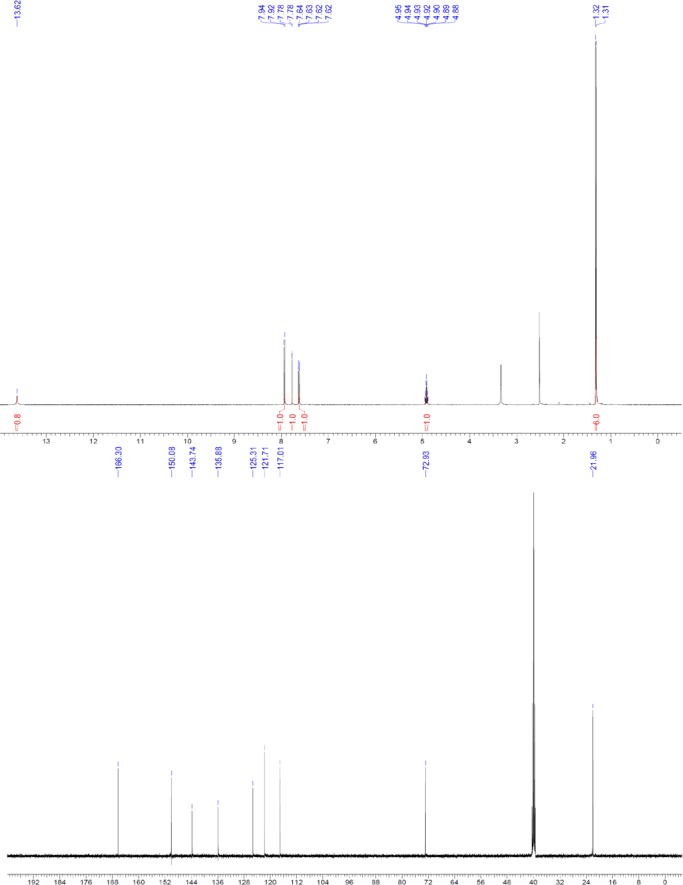
1H and 13C NMR of compound 3b.